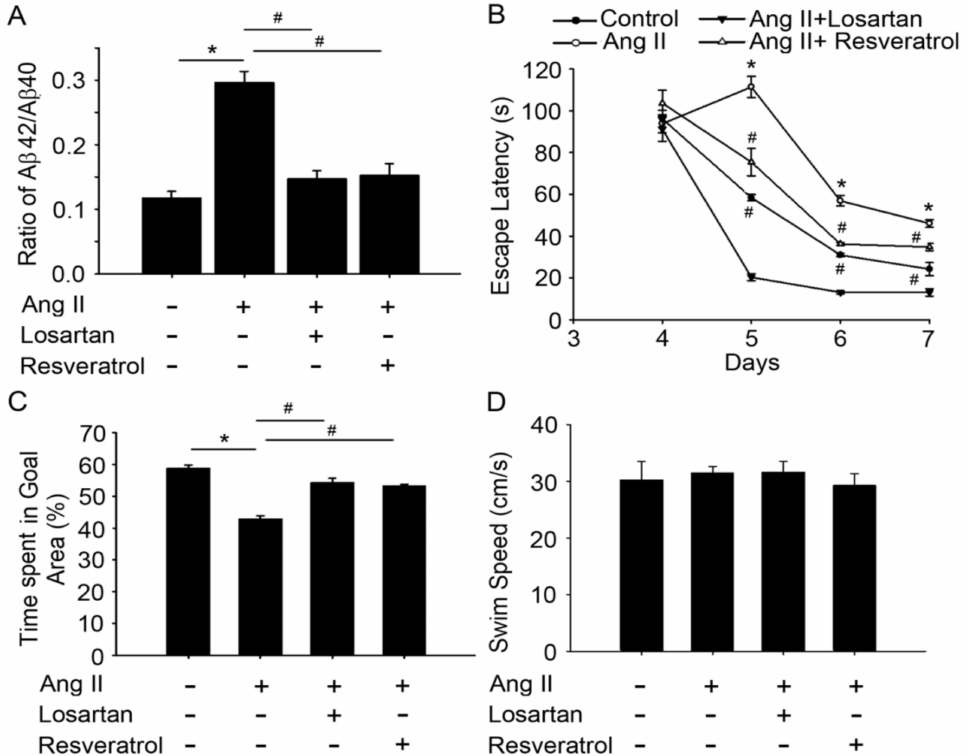
Figure 4. Resveratrol reversed impairments in hippocampal-dependent and contextual memory in rats with Ang-II-induced early AD. ( A ) Bar graph showing the A β 42 production ratio after treatment with Ang-II and/or losartan or resveratrol. Note the significant decrease in Ang-II-induced A β 42 production after the administration of losartan or resveratrol. ( B ) Bar graph showing the latency to find the hidden platform. ( C ) Bar graph showing the time spent in the central area. ( D ) Bar graph showing the swim speed. Note that learning and memory deficits were also reversed in Ang-II-treated rats after losartan or resveratrol administration. The values are presented as the mean ± SEM; n = 6. * p < 0.05 vs. the WKY rats and # p < 0.05 vs. the Ang-II-treated